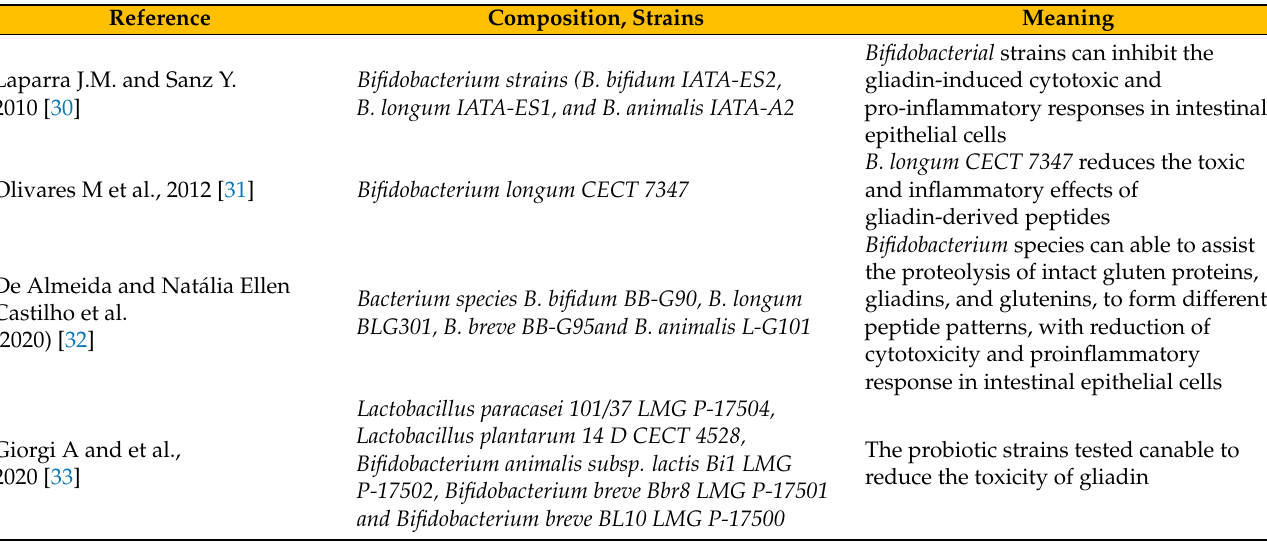
Table 2. In vitro study using Bifidobacterium and Lactobacillus